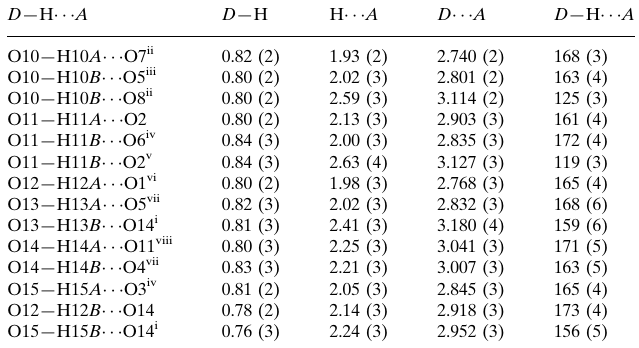
Hydrogen-bond geometry (A˚ , (cid:2)